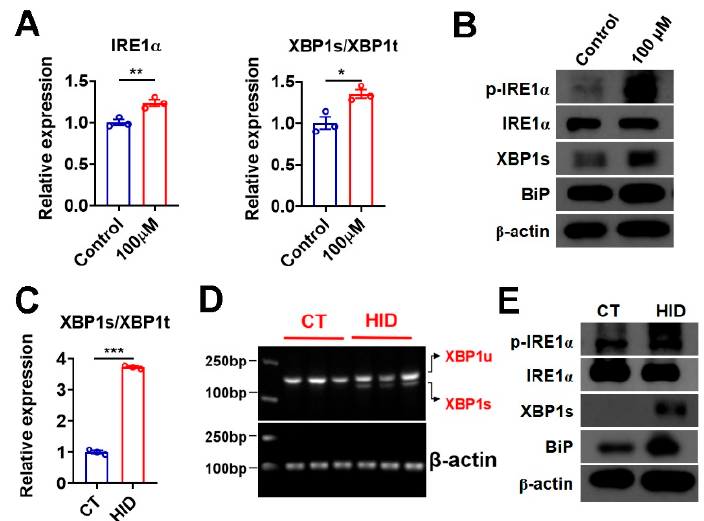
Figure 5. Iodide excess activates XBP1 in murine thyroid and thyroid organoids. ( A ) Relative mRNA levels of IRE1 α (left panel) and the ratio of XBP1s (the spliced active form of XBP1) to XBP1t (total XBP1) (right panel) in murine thyroid organoids incubated with PBS (as Control) or 100 µ M NaI for 24 h ( n = 3). ( B ) Protein levels of p-IRE1 α , IRE1 α , XBP1s, and BiP in murine thyroid organoids incubated with PBS (as control) or 100 µ M NaI for 24 h. Three samples pooled in each group. ( C , D ) The ratio of XBP1s (the spliced active form of XBP1) to XBP1t (total XBP1) ( C ) and agarose gel electrophoresis of XBP1 splicing ( D ) in thyroid tissues of C57 mice after exposure to excessive iodide. Individual data points represent pooled samples, each containing thyroids pooled from three mice in each group ( C , D ). ( E ) Protein levels of p-IRE1 α , IRE1 α , XBP1s, and BiP in thyroid tissues of mice after exposure to excessive iodide. Three samples pooled in each group. HID, high-iodide-diet group; CT, control group; XBP1u, unspliced XBP1. Data are presented as mean ± SEM. Statistical significance was determined by Student’s t -test; * p < 0.05, ** p < 0.01, and *** p < 0.001.